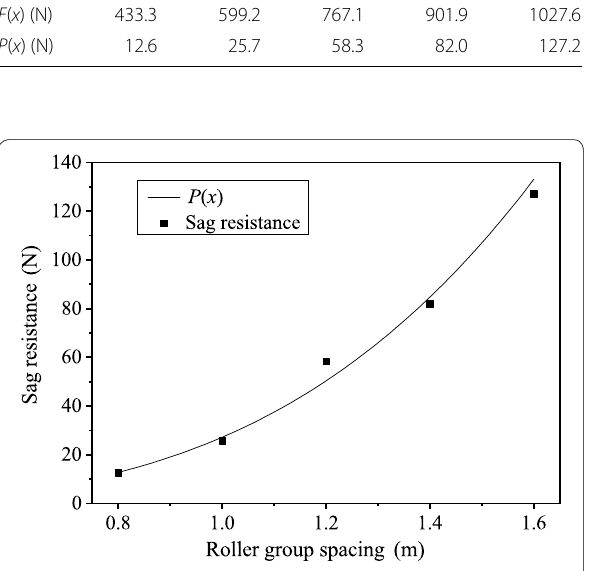
Figure 8 The sag resistance in the case of different rollers spacing and its fitting